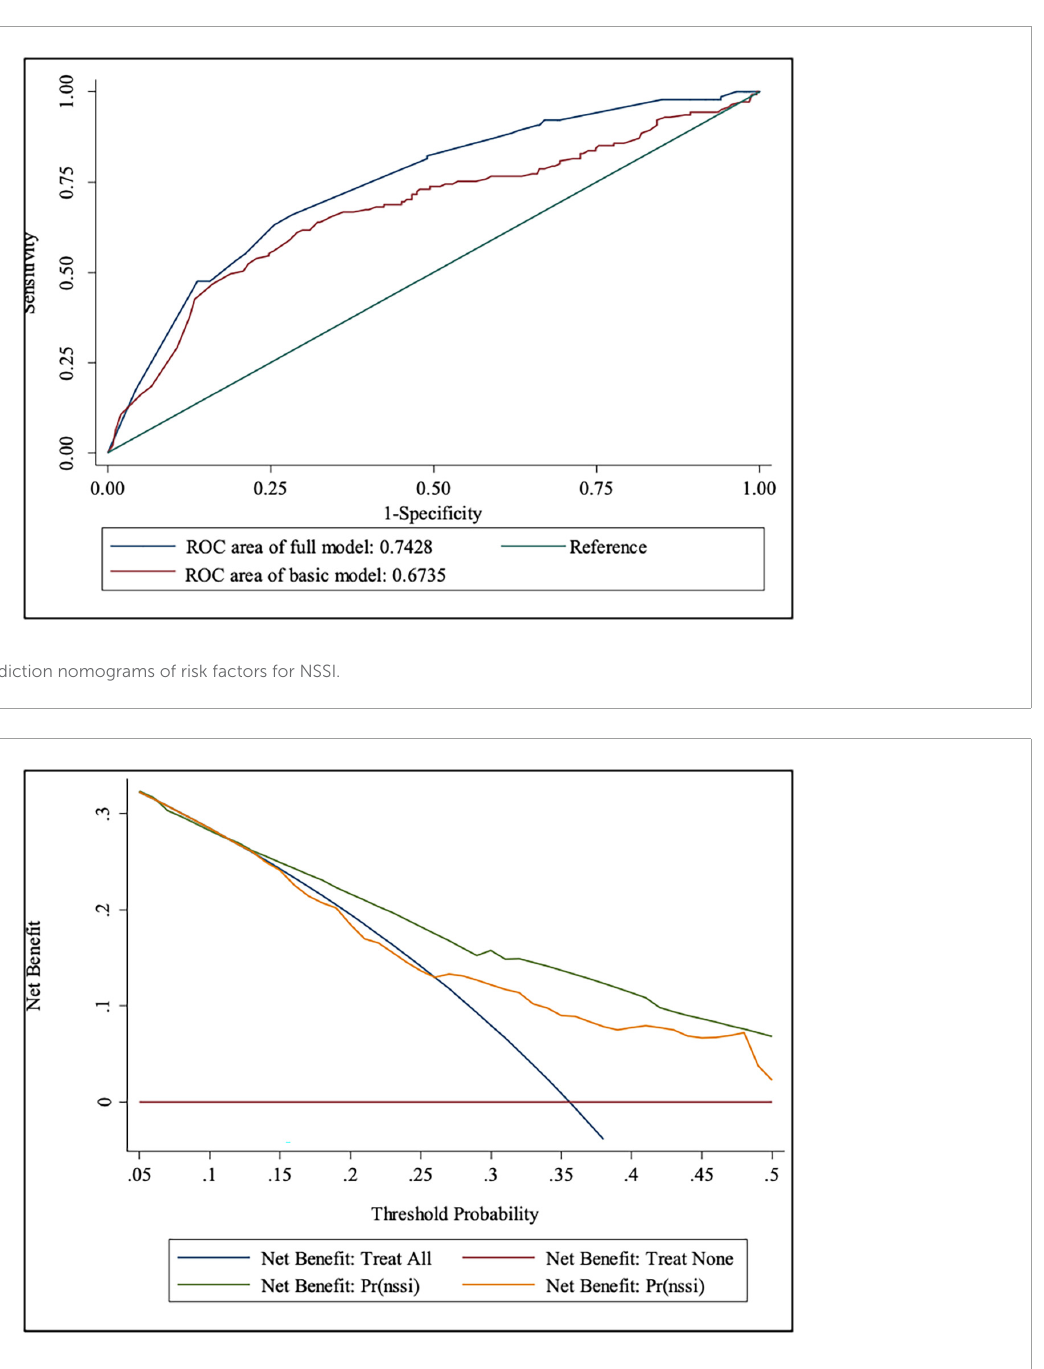
FIGURE5 DCA for the prediction nomograms of risk factors for